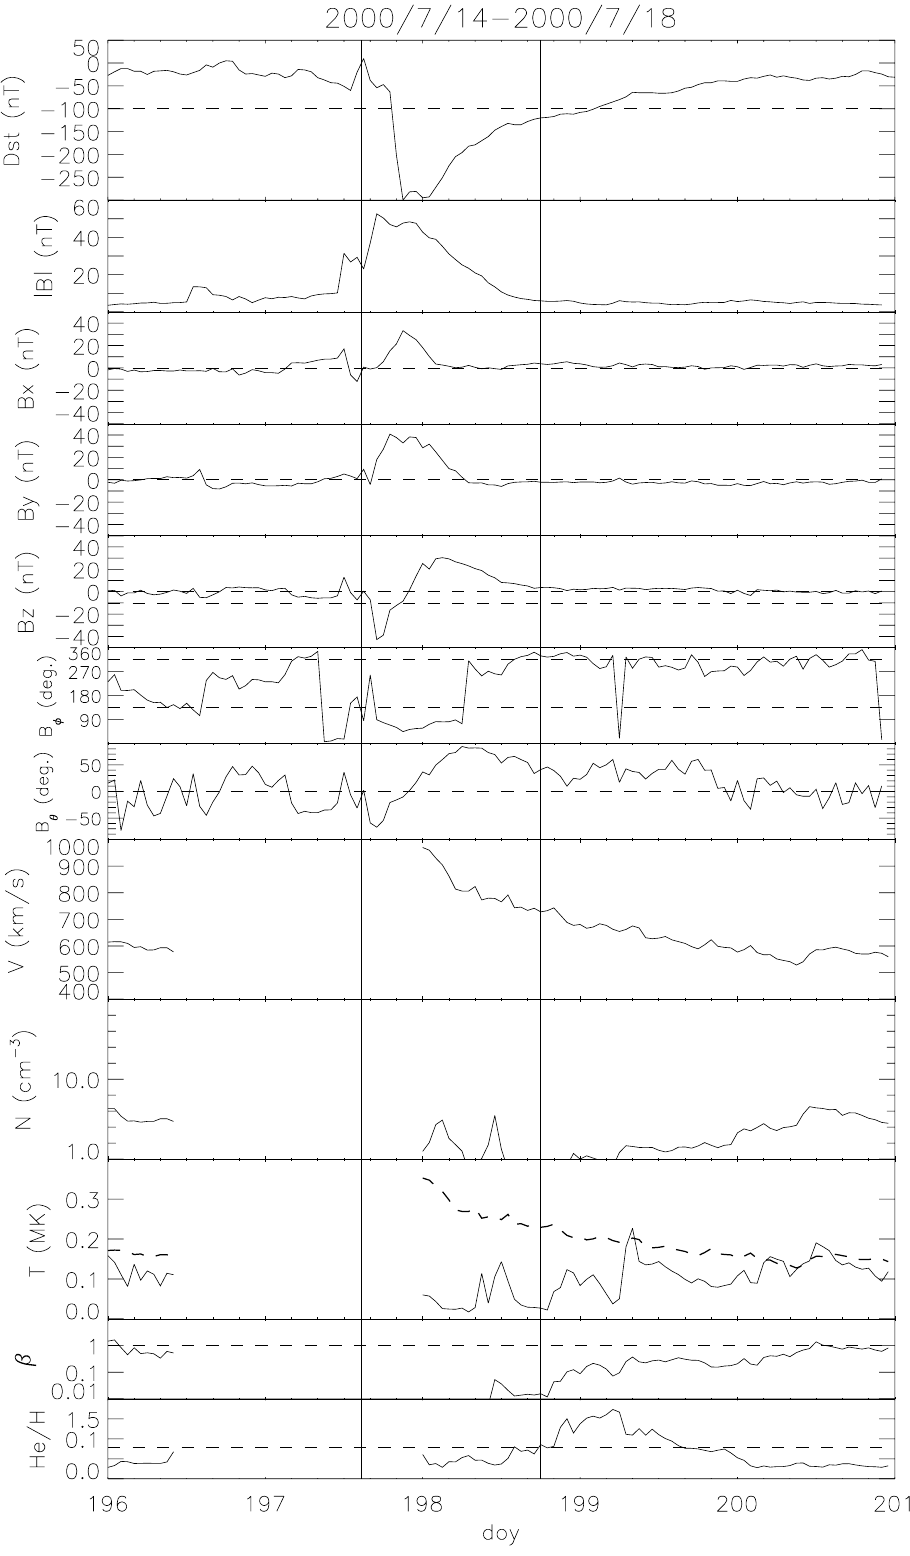
Fig. 2. D st index and solar wind parameters of storm no. 21. Two vertical solid lines show the duration of the geomagnetic storm. Horizontal dashed lines stress some distinct values ( D st index: − 100nT, B z : − 10nT, B-phi: 135 and 315 degrees, β : 1, and He/H: